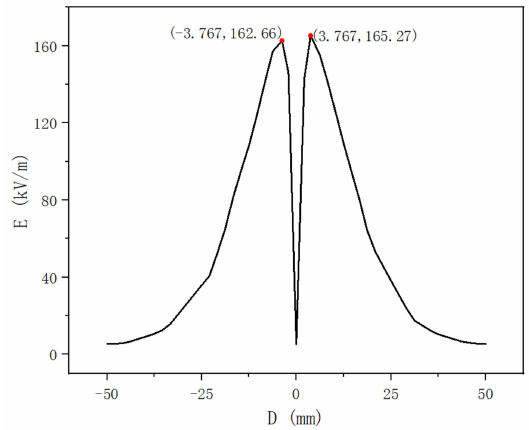
Figure 2. The distribution map of the electric field